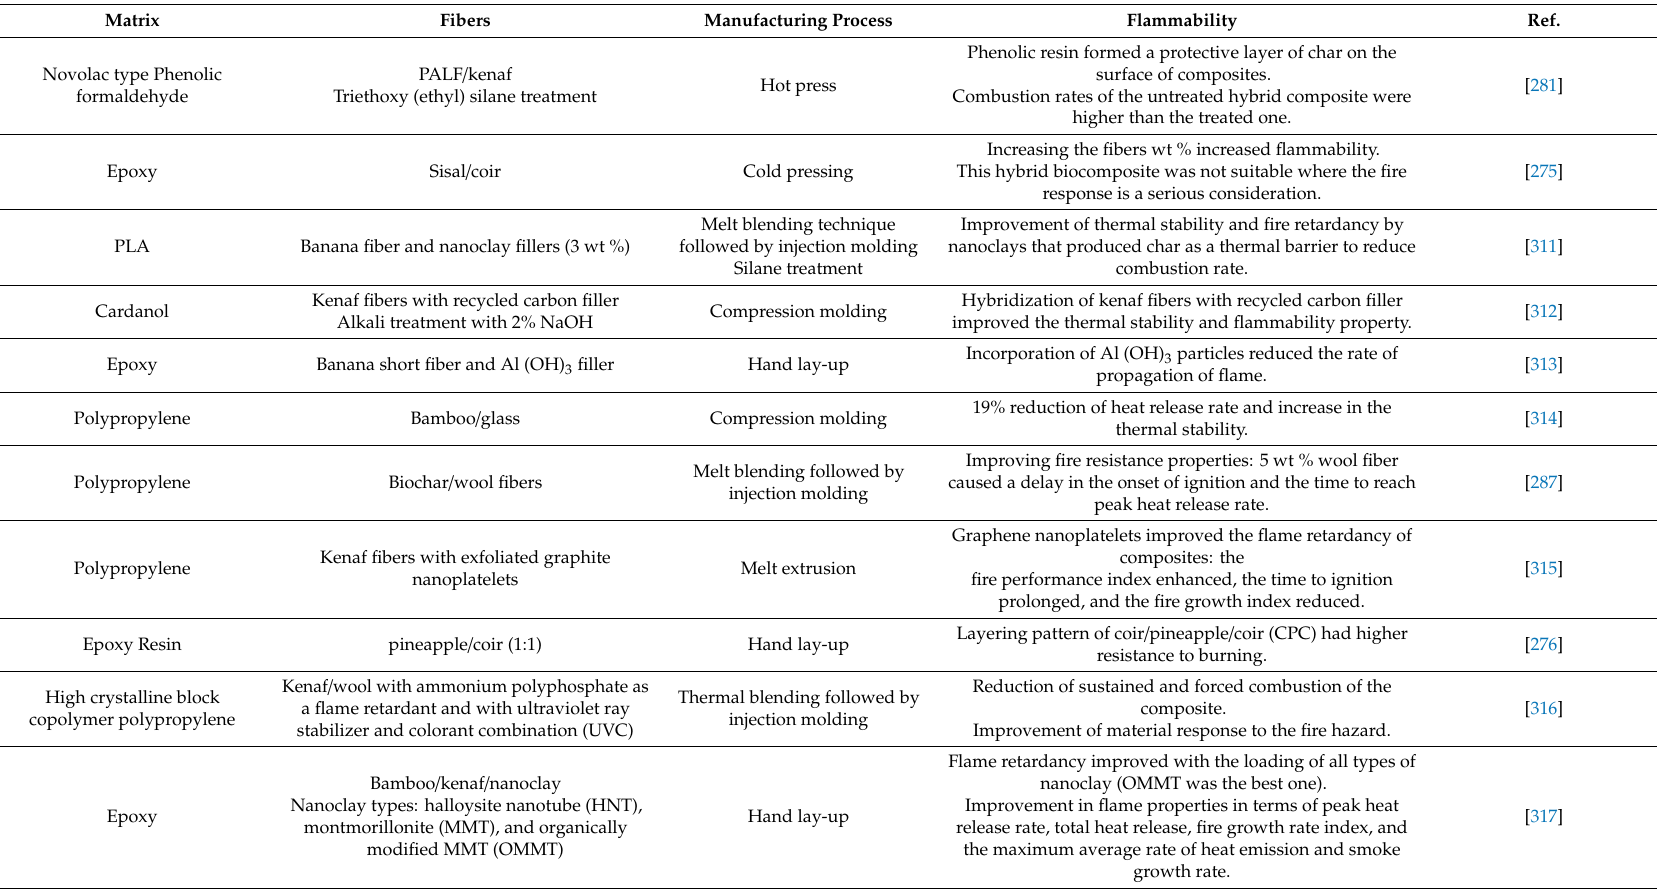
Table 8. Flammability behavior of recently developed hybrid